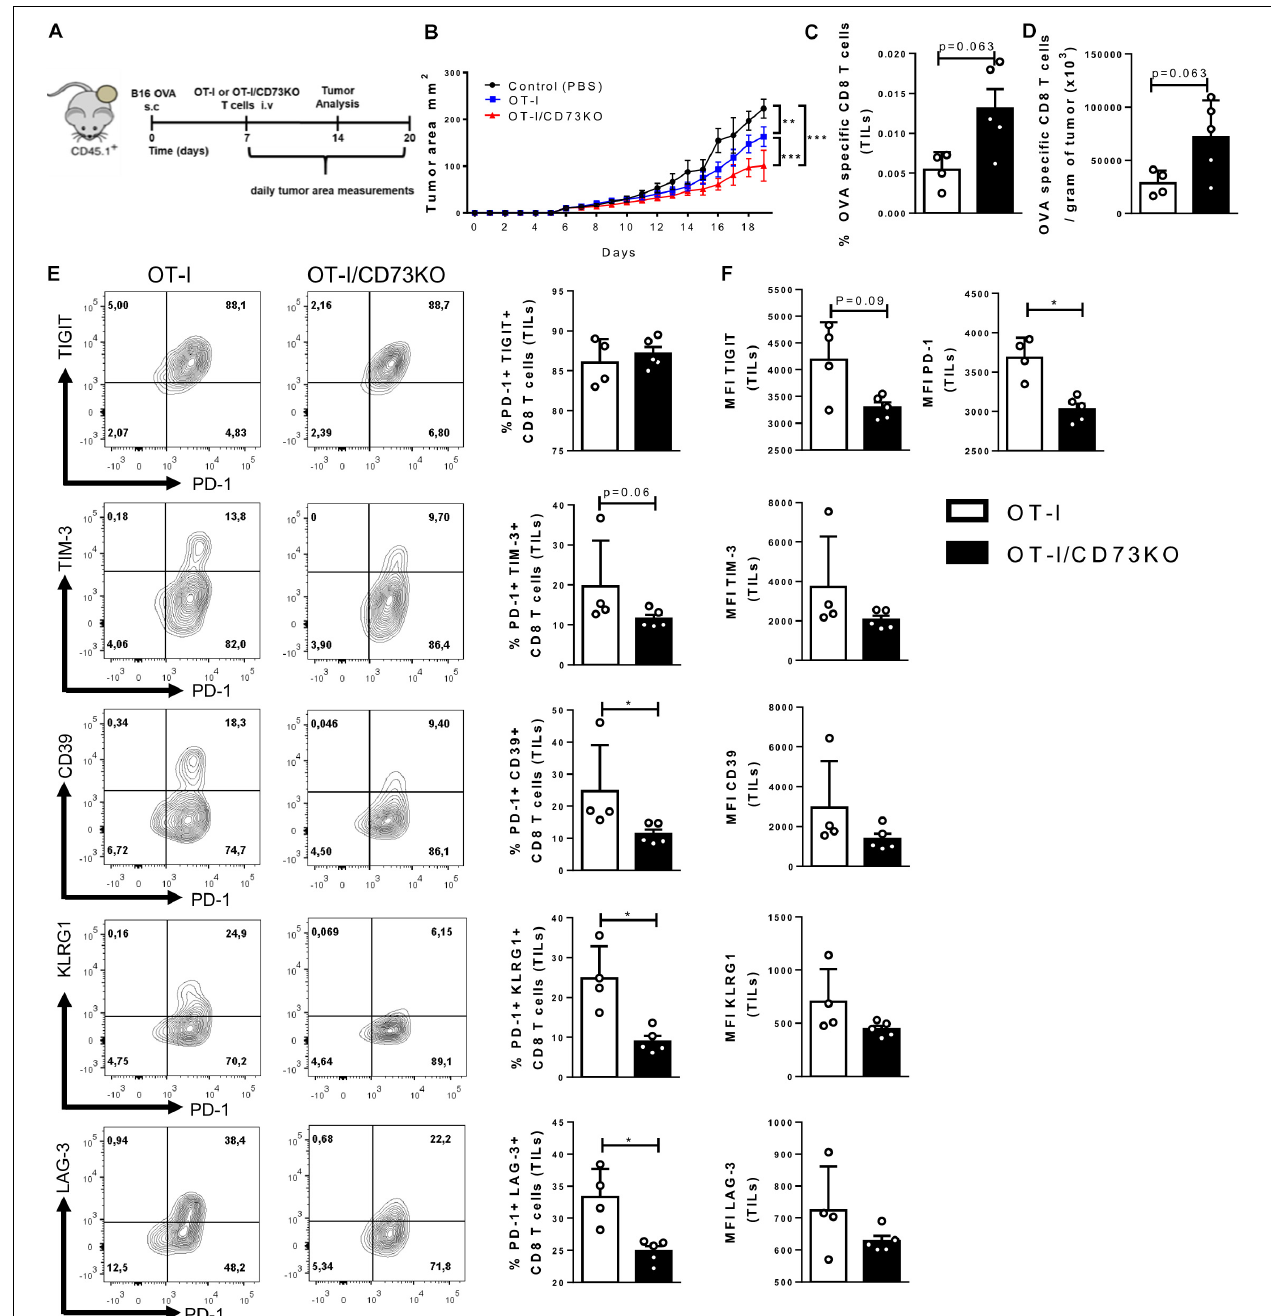
FIGURE 5 | CD73-deficient CD8+ T cells are more effective in controlling tumor growth than WT cells. (A) Diagram showing the experimental setup: B16.OVA melanoma cells were intradermally injected in the back right flank of CD45.1+ mice. Seven days after the tumor challenge, OT-I or OT-I/CD73KO CD8+ naïve T cells (1 × 10 6 cells) were adoptively transferred. Tumor area and tumor-infiltrating T cells were analyzed. (B) Tumor growth curves of CD45.1+ mice that were injected with OT-I or OT-I/CD73KO CD8+ naïve T cells or control (PBS) ( n = 5). Tumor area was calculated by measuring and multiplying perpendicular axes, the results were plotted as the mean ± SEM for each day. (C) The absolute number of OVA-specific CD8+ T cells per gram of tumor ( n = 5). (D) Frequency of OVA-specific CD8+ T cells in the tumor (TILs) ( n = 5), (E) Dot plots, and bar graphs depicting the expression and frequency of positive cells within the adoptively transferred cells (CD45.2+/CD8+ gate) for the different inhibitory receptors. (F) MFI of inhibitory receptors in the adoptively transferred cells (CD45.2+/CD8+ gate). Data is presented as the mean ± SEM. Significance was determined using two-way repeated measured ANOVA with Bonferroni’s correction post hoc at day 19 (B) , and unpaired two-tailed Mann–Whitney test (C–E) . * p < 0.05, ** p < 0.01, *** p < 0.001, **** p < 0.0001 ( B , Two-Ways ANOVA), ( C–E , Two-tailed Mann–Whitney Test).